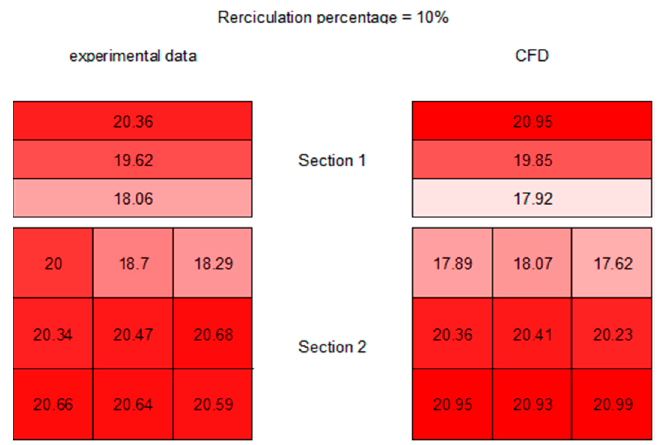
Figure 7. Comparison between experimental and Computational Fluid Dynamics (CFD) data for 10% WGR—O 2 mole fraction.